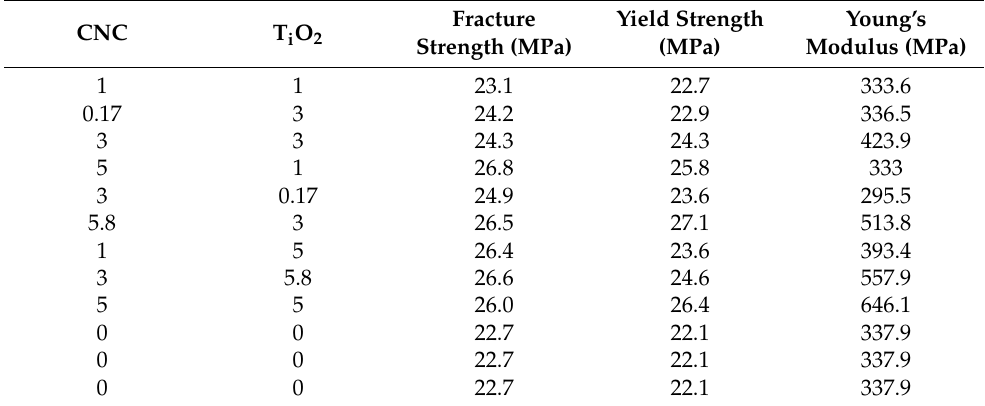
Table 6. Summarized predicted mechanical properties of the HDPE nanobiocomposites by